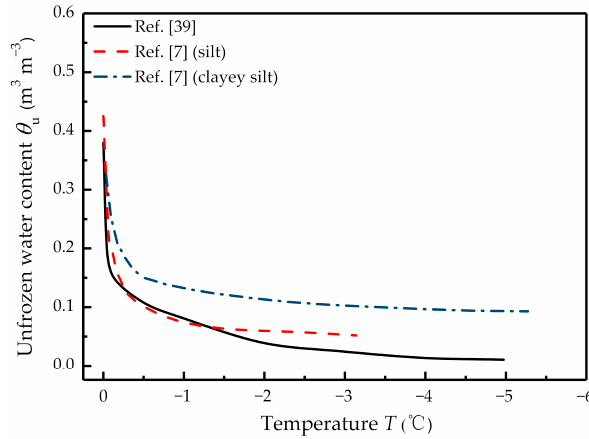
Figure 5. Soil freezing curve.